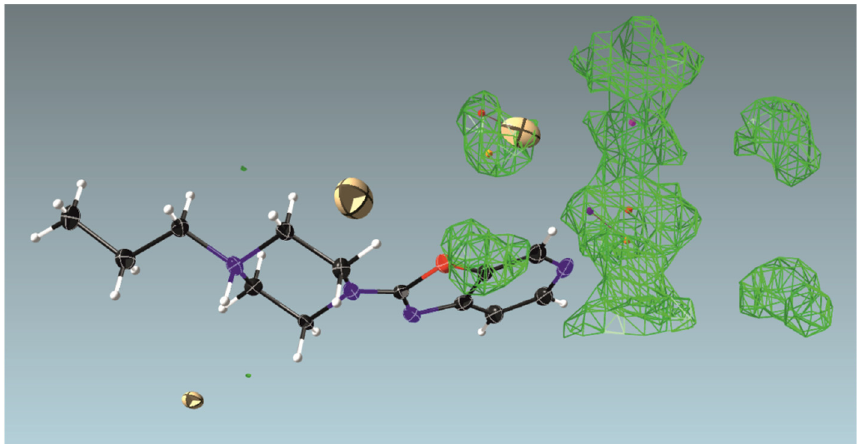
Figure 4. Difference electron density map for 3 showing the area of electron density representing delocalized solvent molecules (probably DMF and water) and probable sites of disordered bromide anions (two big yellow ellipsoids), which were excluded from the refinement and instead SQEEZE procedure was applied. Drawing prepared with ShelXle.